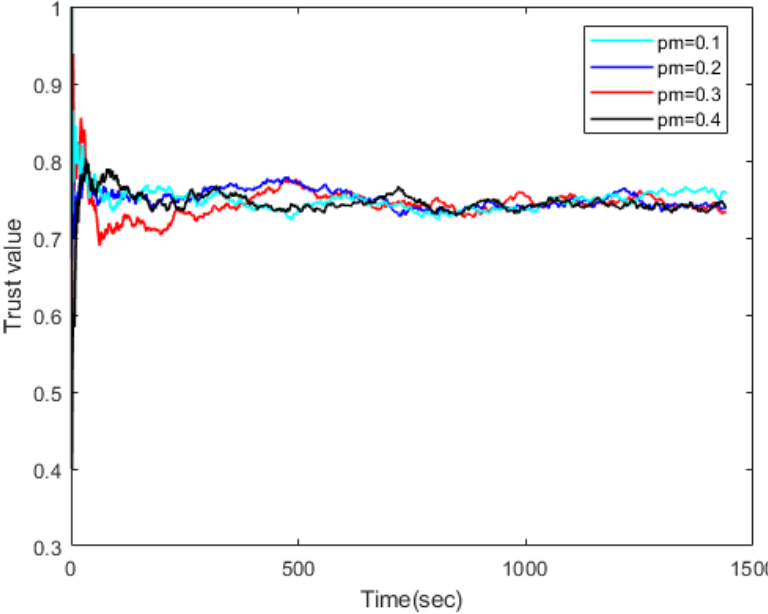
Figure 2. Trust value of a good node under adaptive control with pm ranging from 0.1 to 0.4.